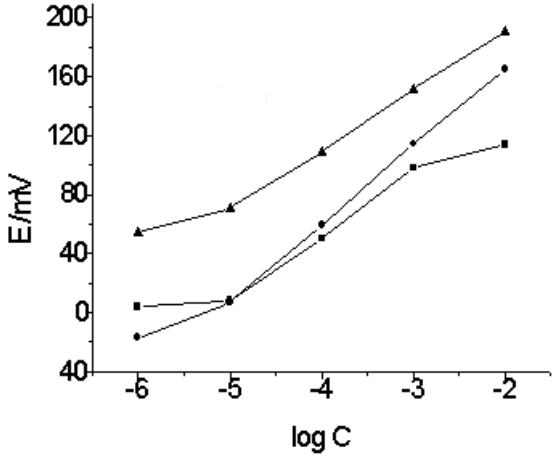
Figure 1. Optimization of plasticizers. DBP( ■ )(the PVC membrane composition: DBP 64.0 wt%, PVC 34.5 wt%, MC-TPB 1.5wt%);DOP( ● ) (DOP 68.0 wt%, PVC 31.5 wt %, MC-TPB 0.5 wt%); DNP( ▲ ) (DNP 60.0 wt%, PVC 39.0 wt%, MC-TPB 1.0